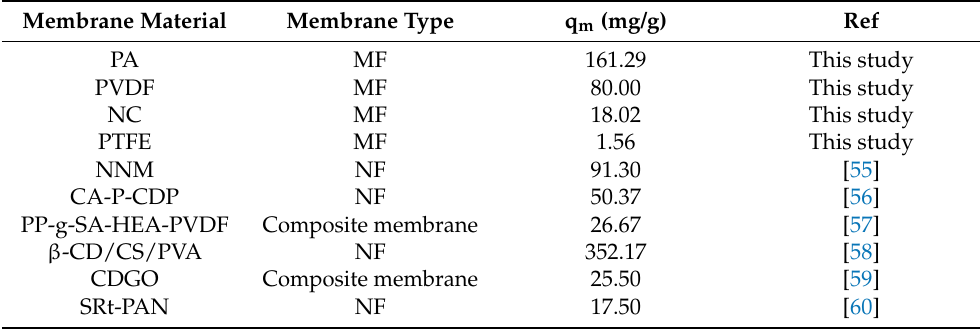
Table 4. Comparison of maximal adsorption capacity of BPA by various